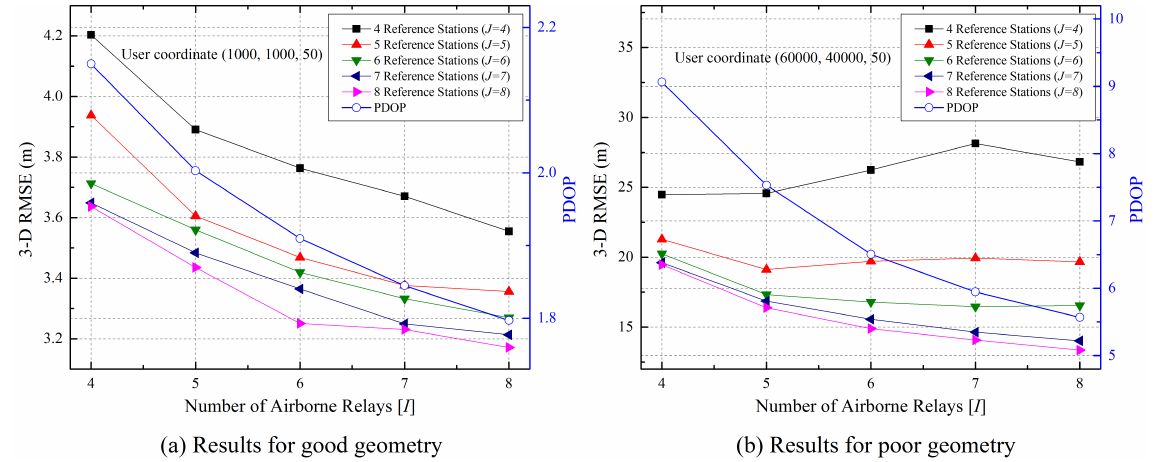
Figure 6. Performance with various combinations of